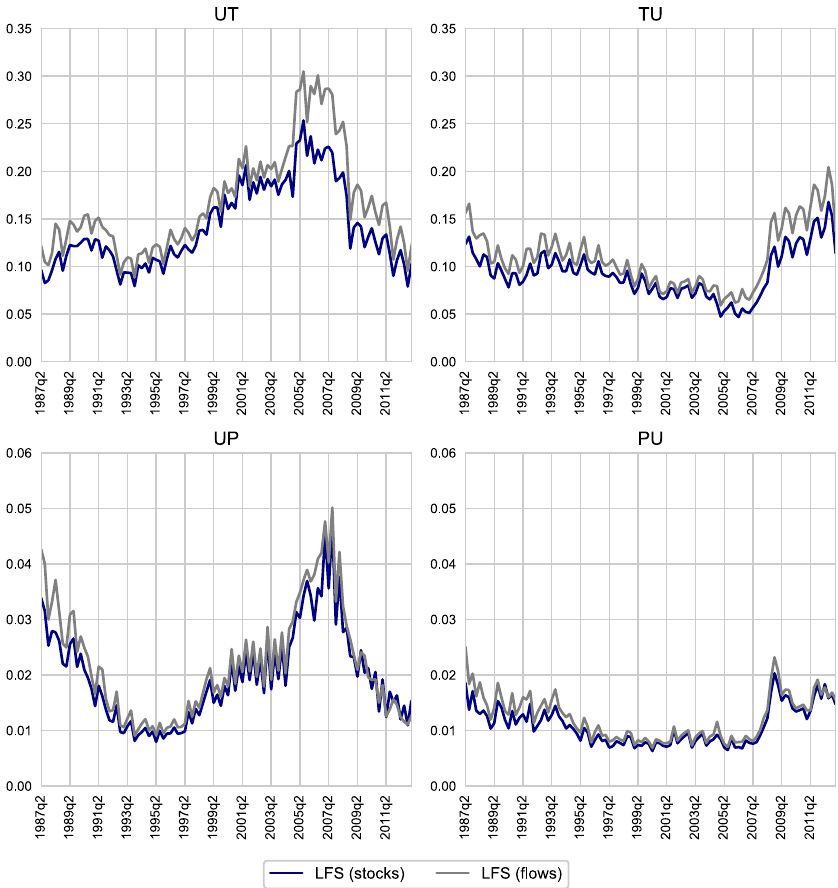
Fig. 20 Labour market flows in LFS. Source : LFS. Shows quarterly observed transition rates, using as the denominator: the observed stock of workers in a given state (stocks) and the sum of the flows originating for a given state